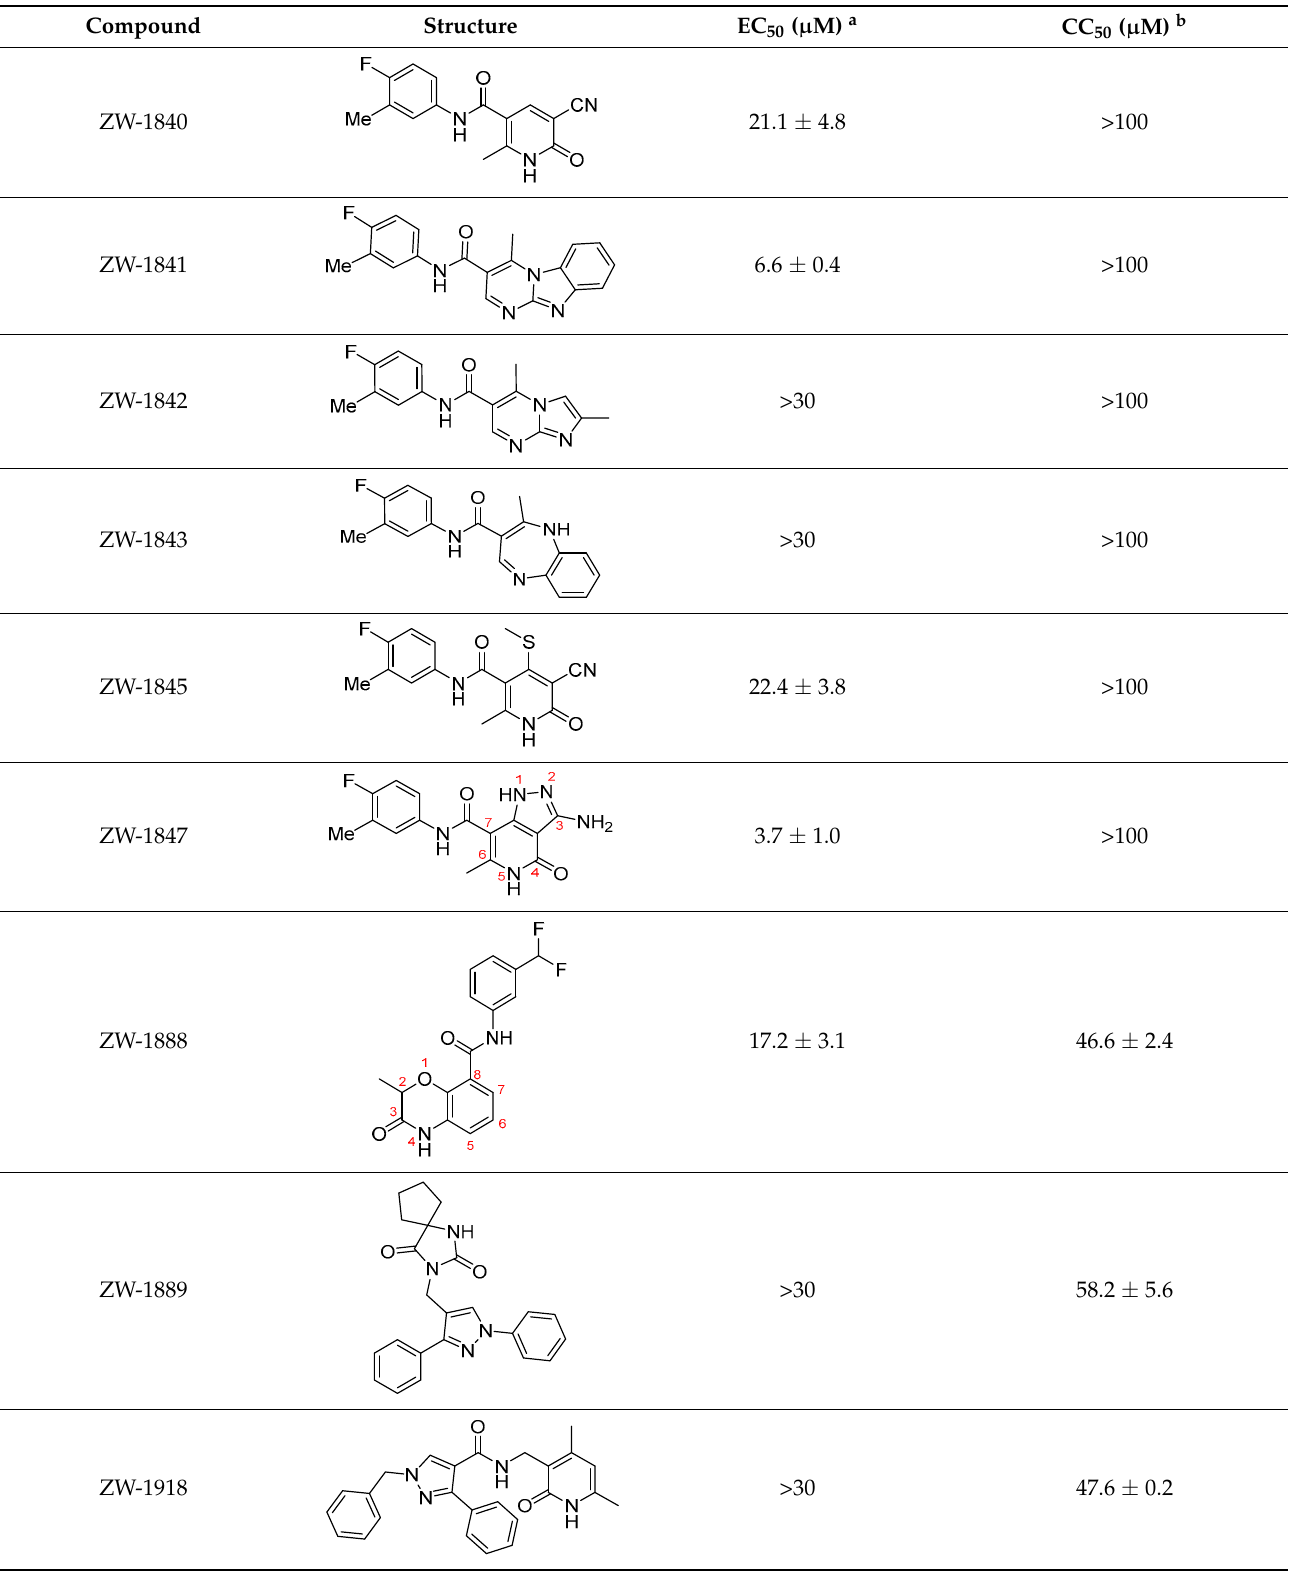
Figure 6. TSA profiles of selected hit compounds that bind to HBV Cp and affect capsid formation and stability. HBV Cp melting curves in the presence of 1% DMSO are shown in red; HBV Cp melting curves in the presence of 20 µM compound (ZW-1841 ( A ), ZW-1847 ( B ), and ZW-1888 ( C )) and 1% DMSO are shown in black. Table 1. Antiviral and cytotoxicity data of the TSA hits. Compound